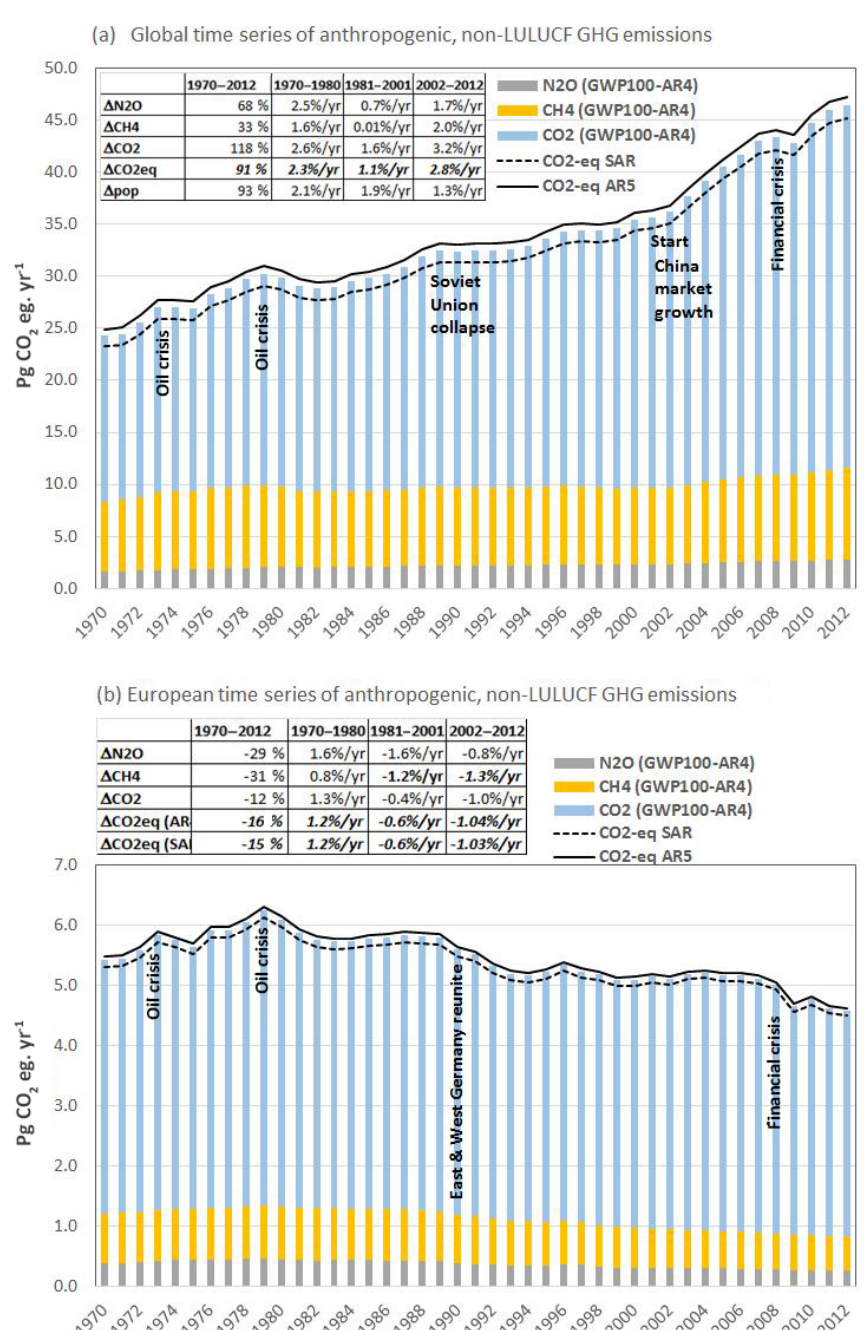
Figure 3. Time series 1970–2012 of fossil fuel CO 2 , CH 4 and N 2 O global emissions from human activities excluding the LULUCF sector with global total (a) and European total (b) . The stacked bars use AR4 GWP-100 values, whereas the dashed line and full line indicate the total CO 2eq of the three gases in the case where the SAR and AR5 GWP-100 values are respectively